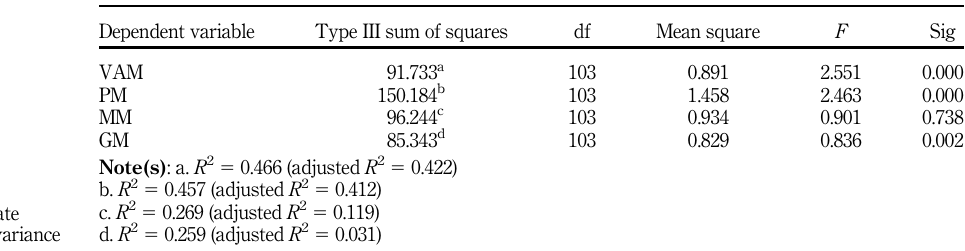
Table 10. The univariate analysis of